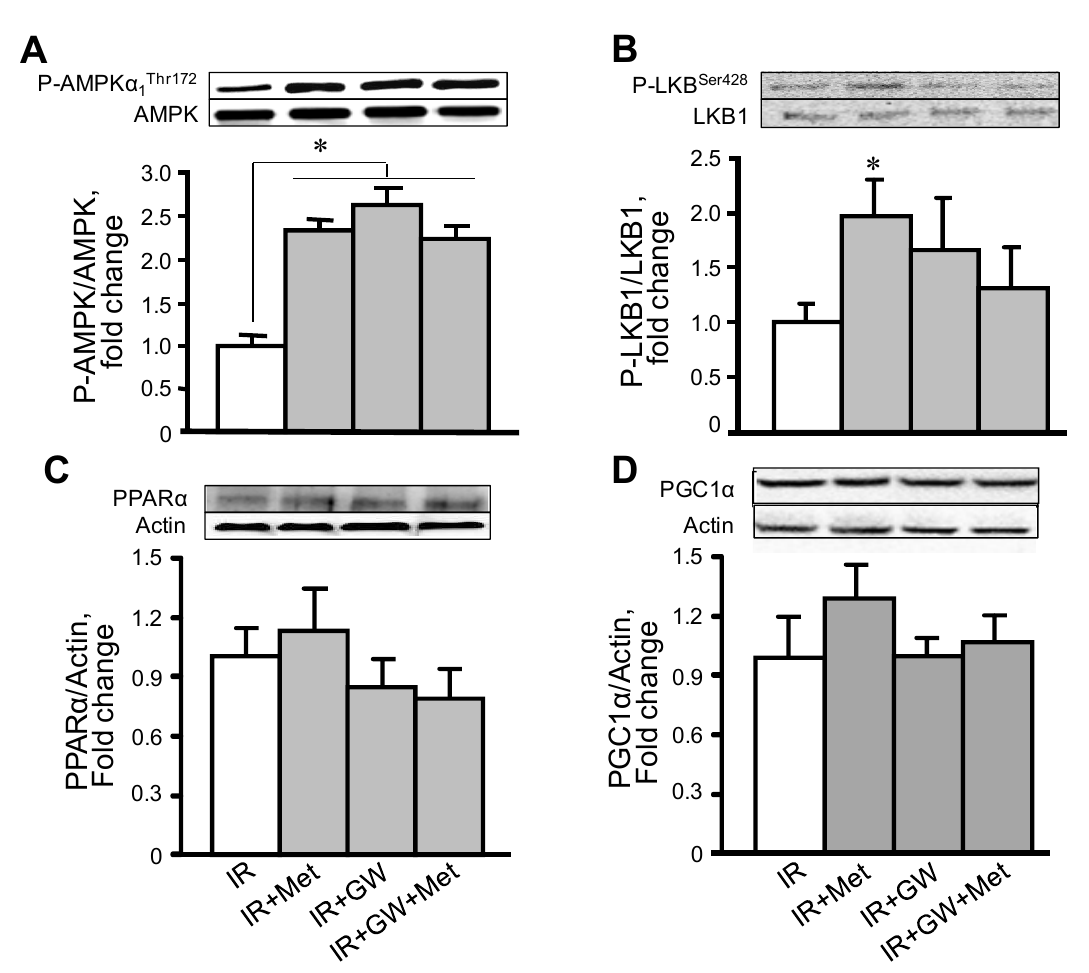
Figure 6. The effects of metformin (Met) on phosphorylation of AMPK α 1Thr172 ( A ), LKB1 ( B ), PPAR α ( C ) and PGC-1 α ( D ) expression. Representative Western blot images of P-AMPK α 1Thr172 , AMPK, P-LKB1 Ser428 , LKB1, PPAR α , PGC-1 α and actin are shown for each graph (upper panels). Quantitative data are expressed as fold change relative to IR group (lower panels). * p < 0.05 IR+Met, IR+GW or IR+Met+GW vs.